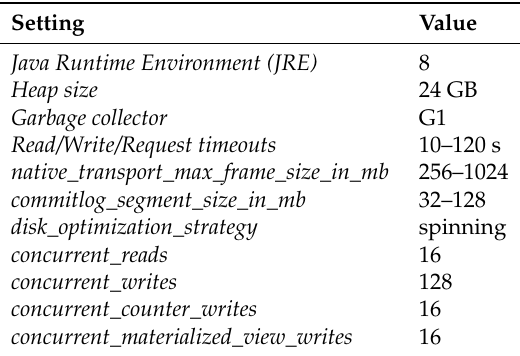
Table A2. Relevant Cassandra configuration